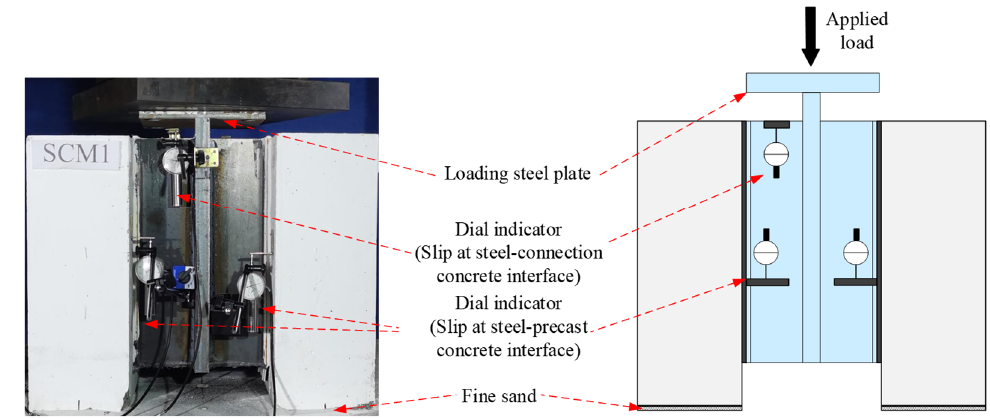
Figure 2. Test setup and measuring point arrangement.